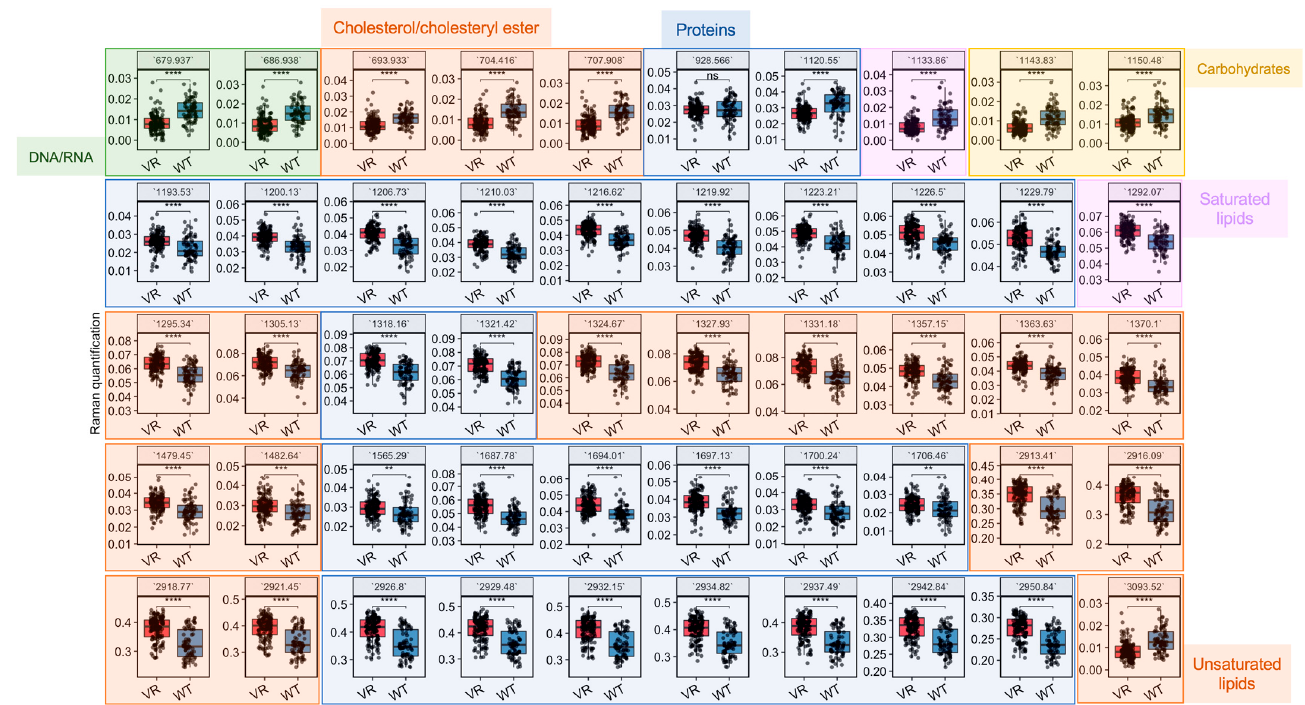
Figure 4. Quantification of biomolecules in Caco-2 and VR Caco-2 based on their SCRS. Differential Raman bands selected based on the LDA model were quantified and compared between Caco-2 and VR Caco-2 cells. All Raman bands are colour-coded as green (DNA/RNA), orange (lipids) or blue (proteins). Statistics was done with Student’s t -test (ns: p > 0.05; **: p < 0.01; ***: p < 0.001; ****: p < 0.0001). VR: VR Caco-2; WT: Caco-2.